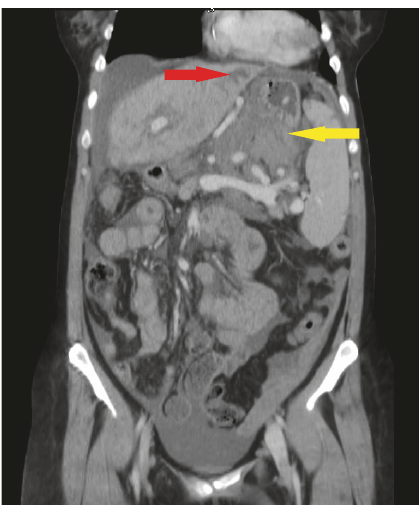
Figure 1: Coronal image from abdominal CT with contrast captures the development of hemoperitoneum (yellow arrow) from splenic varices and hypodensity in left lobe of liver suggestive of cholangio- carcinoma (red